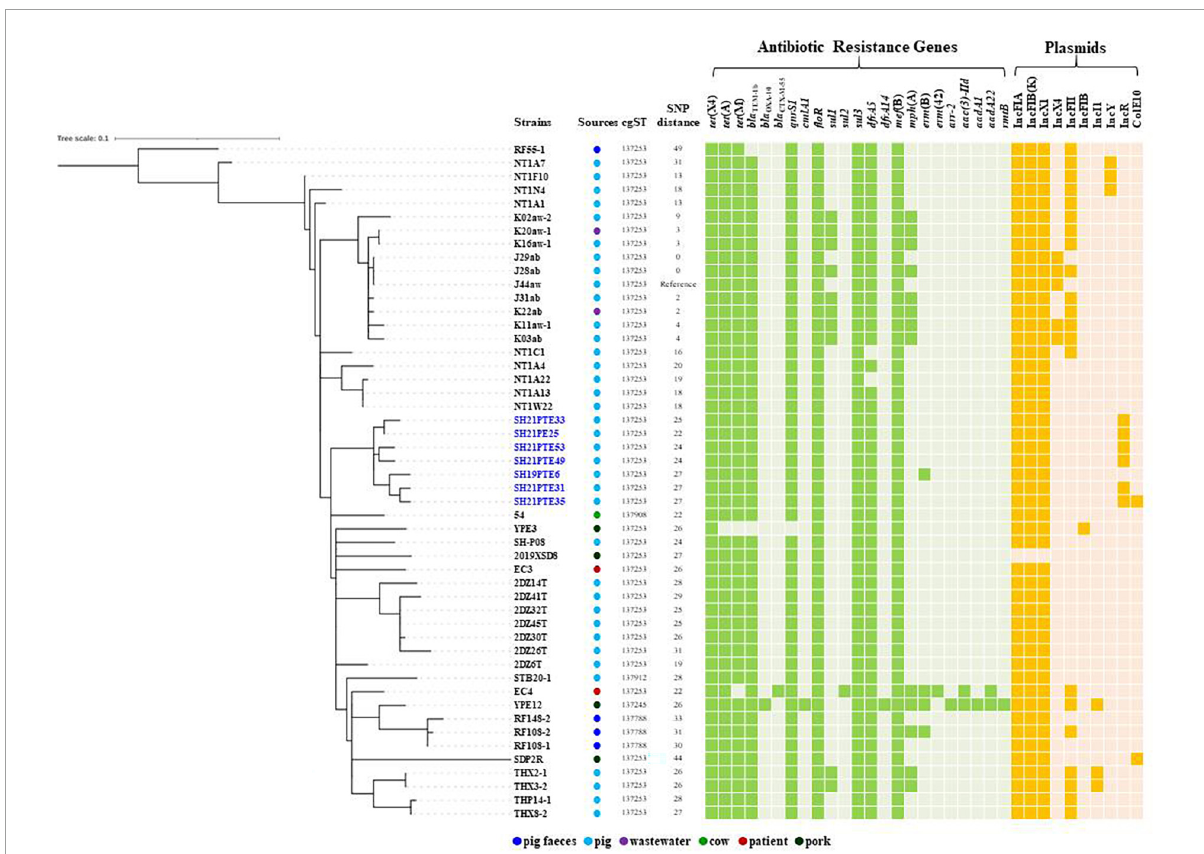
FIGURE1 The maximum likelihood tree of tet (X4)-positive E. coli ST761 isolates in this study compared with tet (X4)-positive E. coli ST761 isolates from NCBI based on cgSNP analysis. Antibiotic resistance genes and plasmid replicons with > 95% sequence homology and > 60% coverage are shown. The isolates obtained in this study and in the same pig farm were indicated in